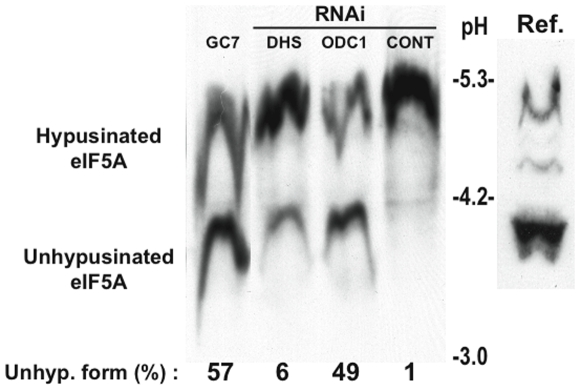
Isoelectric focusing analysis quantifies eIF5A hypusination.U2OS cells were transfected with control (CONT), DHS-specific (DHS), or ODC1-specific (ODC1) siRNAs or treated with GC7 (10 µM) for 1 hour prior to processing for IEF analysis. U2OS cells expressing recombinant eIF5A (K50A) was used as a reference standard for unhypusinated eIF5A. The percentage of unhypusinated eIF5A in each sample was quantified using densitometric analysis.